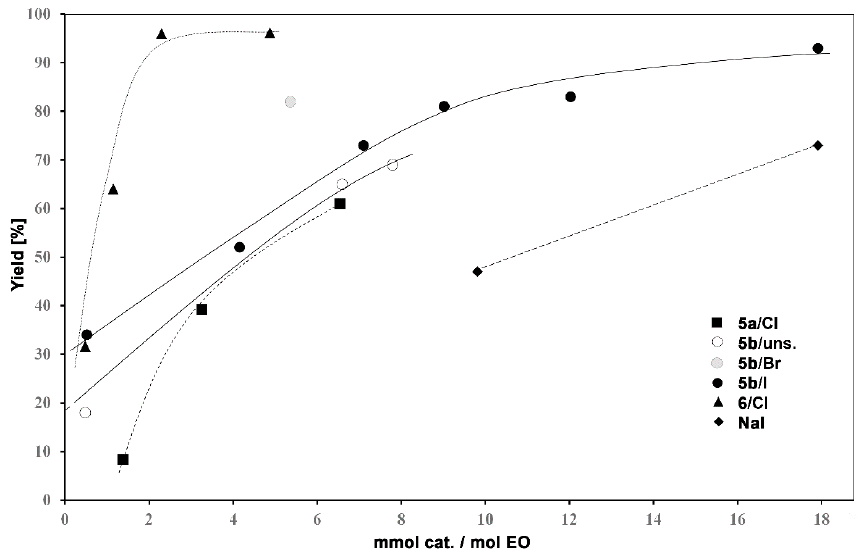
Figure 8. Reaction yields in relation to the type and amount of the catalyst used for carbon dioxide addition (130 ◦ C,